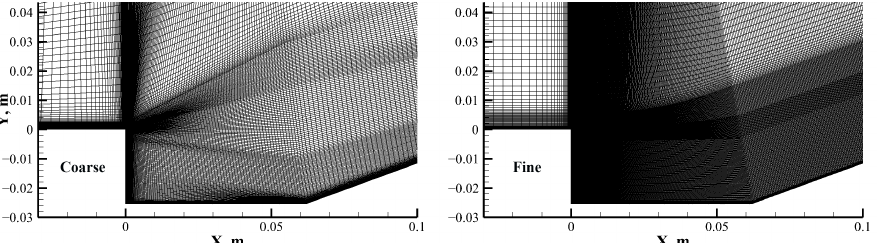
Figure 2. Schematic diagram of grid spanwise section of the Settles supersonic flow ( left : coarse, right :